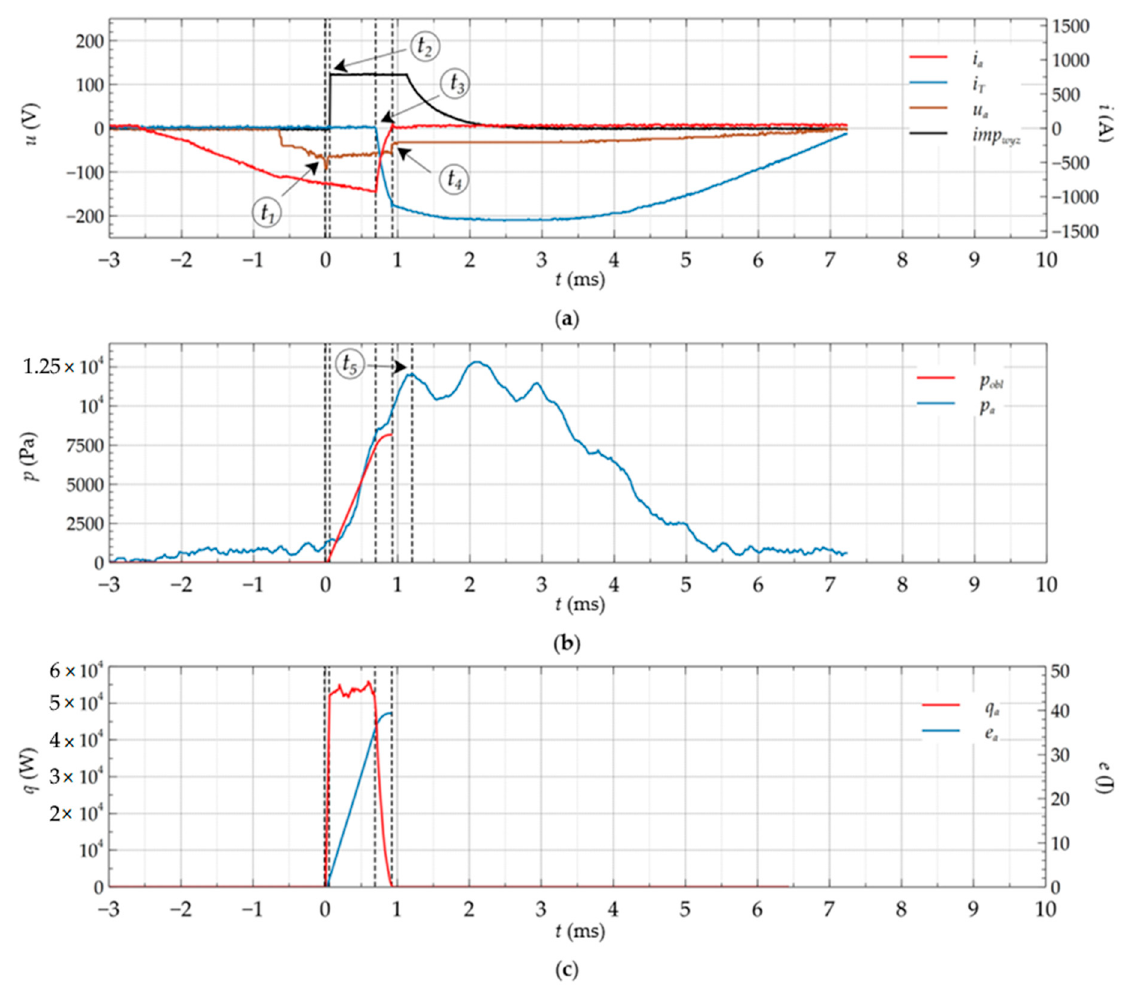
Figure 12. Waveforms as a function of the arc fault duration: ( a ) arc voltage u a , current in the arc branch i a , current in Figure 12 the MSAE i T branches, arc flash detection pulse imp wyz , ( b ) measured pressure pa and calculated P obl inside the electrical junction box, ( c ) arc power q a and arc energy e a as a function of the arc disturbance